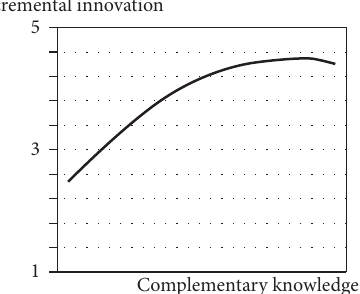
Figure 2: The U-shaped relationship between complementary knowledge coupling and firms’ incremental Table 4: Moderating effect test of government support policies.